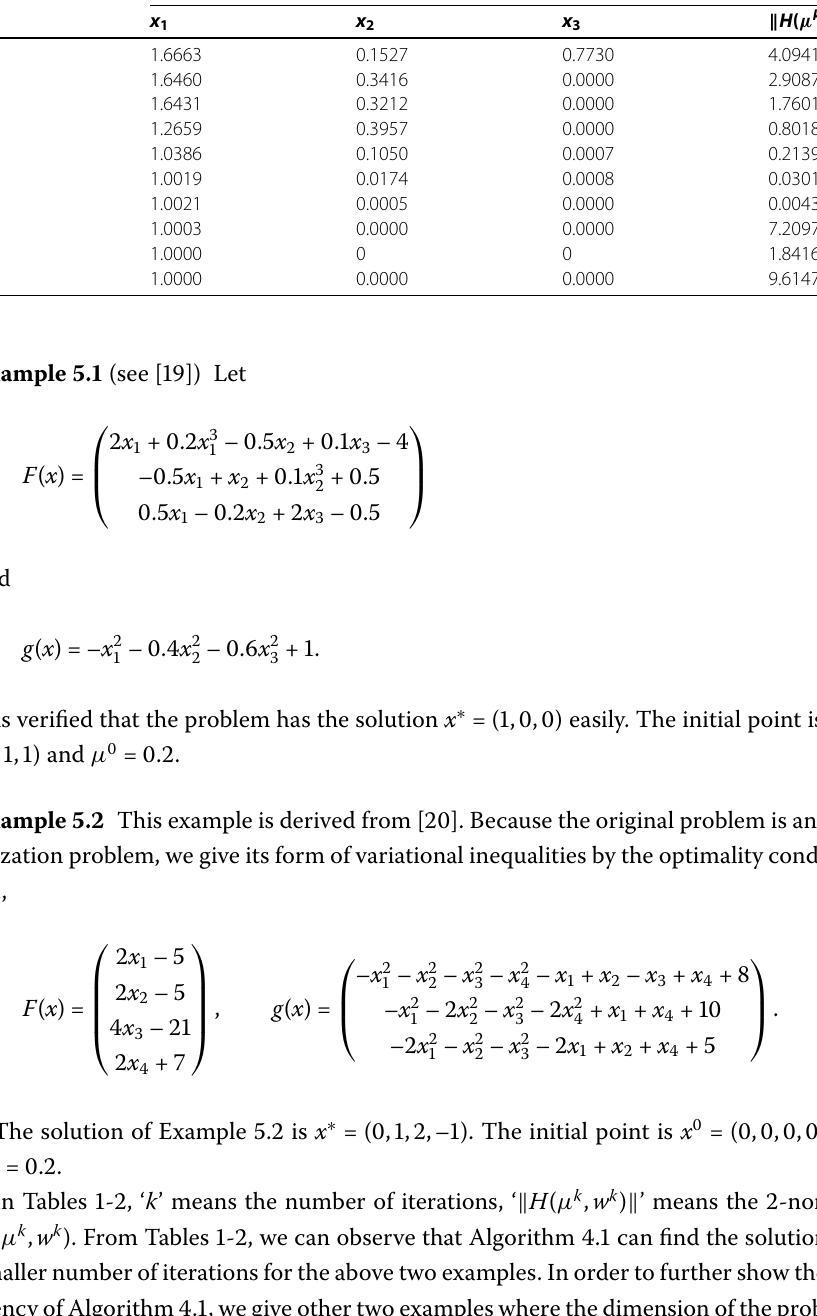
Table 1 Numerical results for Example 5.1 with x 0 = (0,1,1) Example